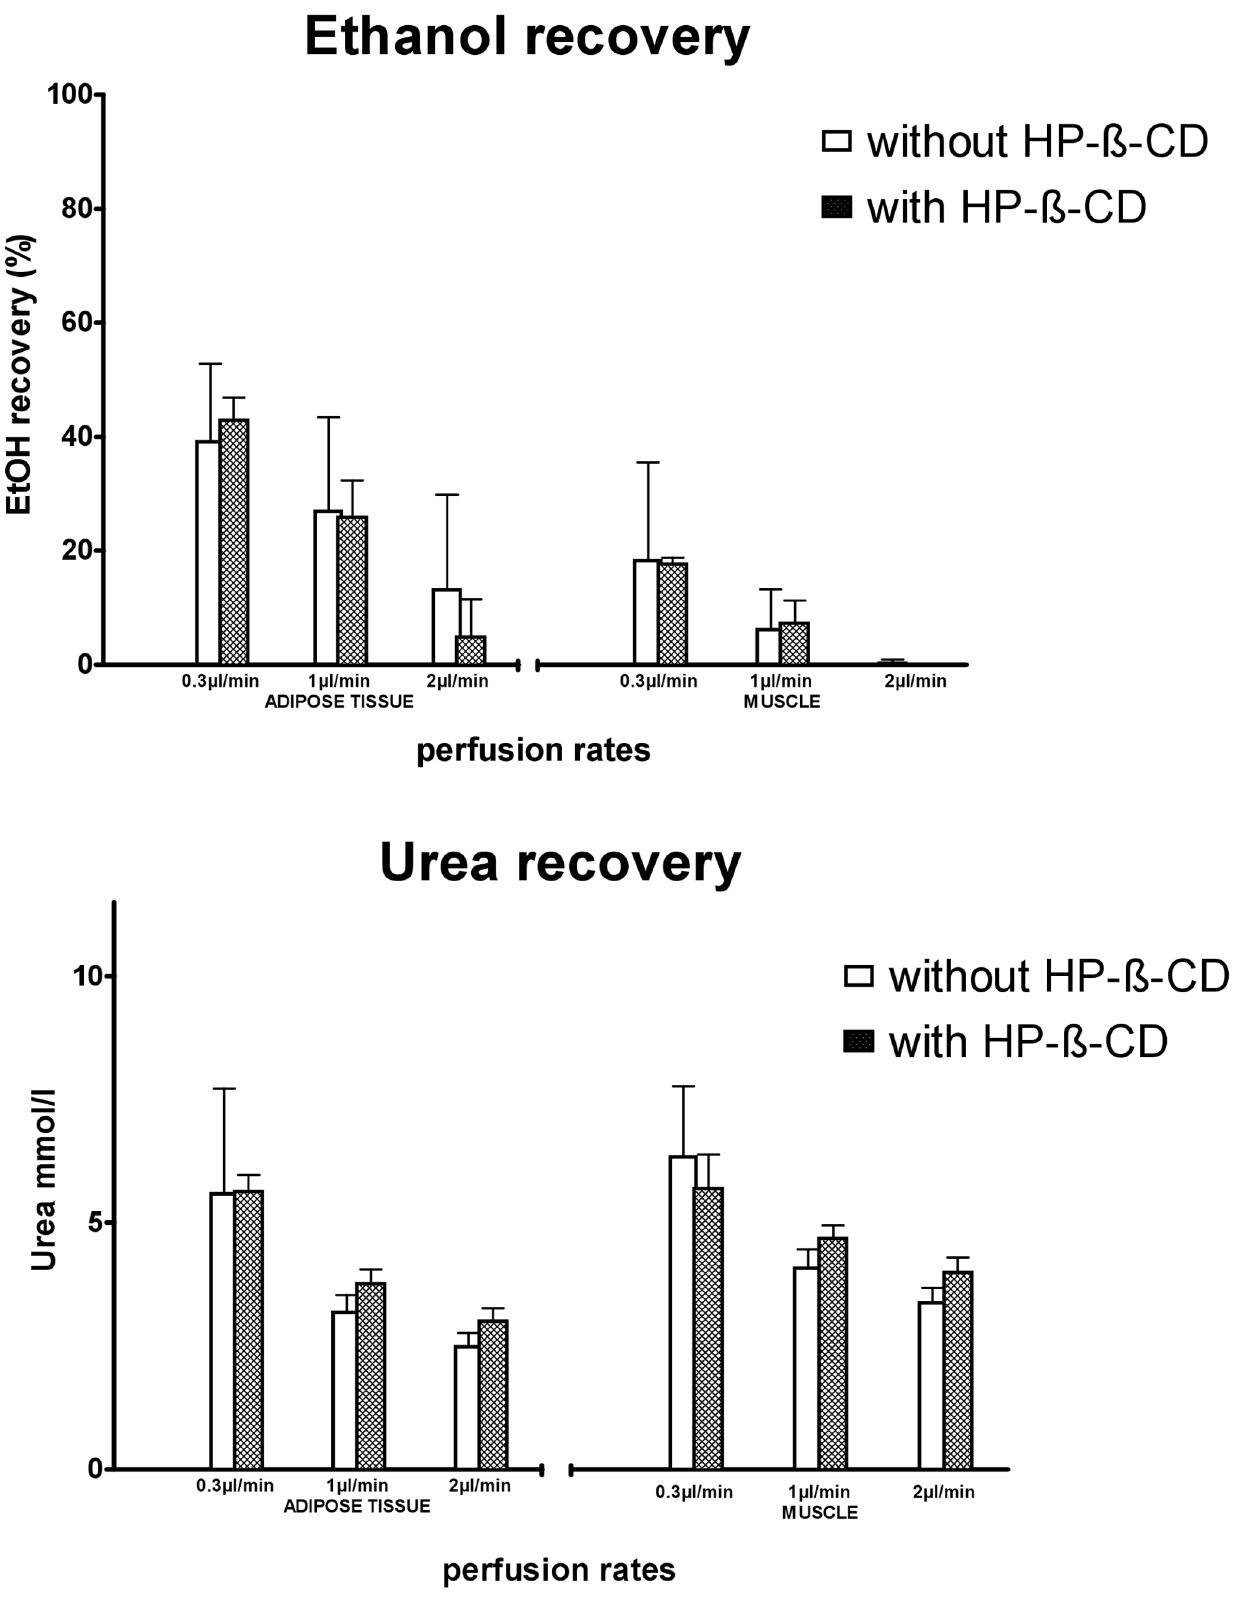
Figure 3. Urea and Ethanol recovery in adipose tissue and skeletal muscle Ringer perfusion fluids with and without HP-ß-CD were compared at different flow rates (data: mean 6 SEM).